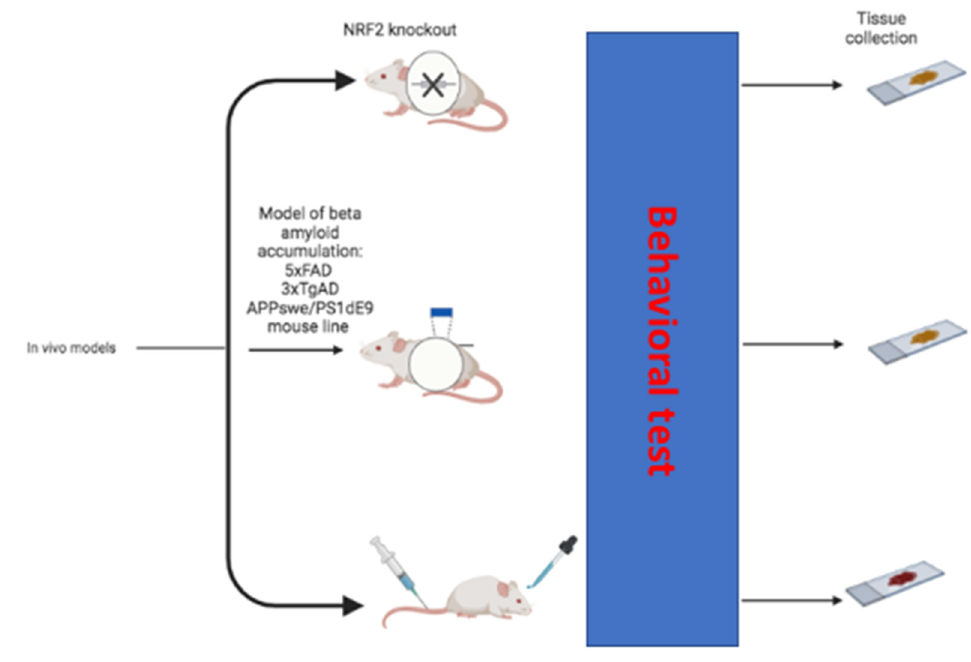
Figure 3. In vivo models used to demonstrate the deleterious consequences of loss of NRF2 and the cognitive enhancing effects of NRF2 activation (created in BioRender.com, accessed on 20 July